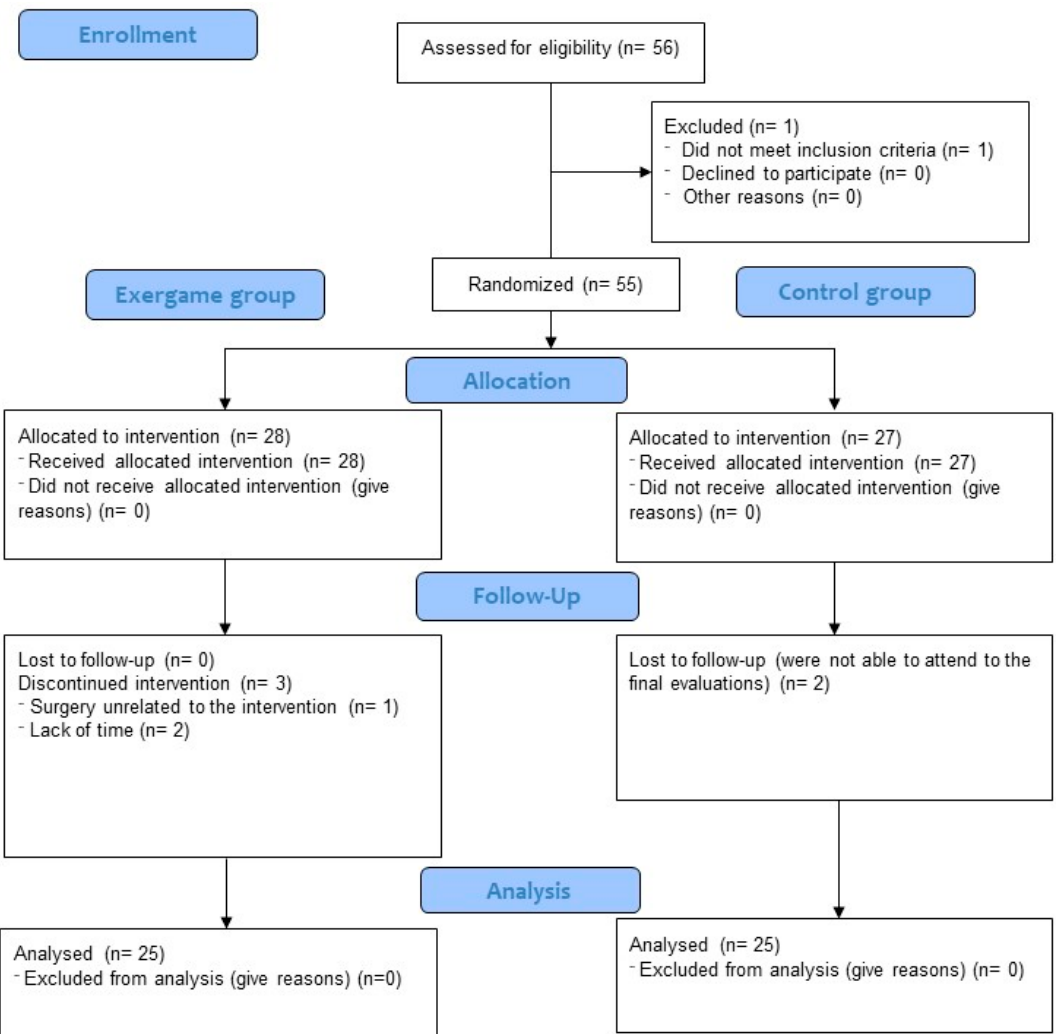
Figure 1. Flow chart of participants.